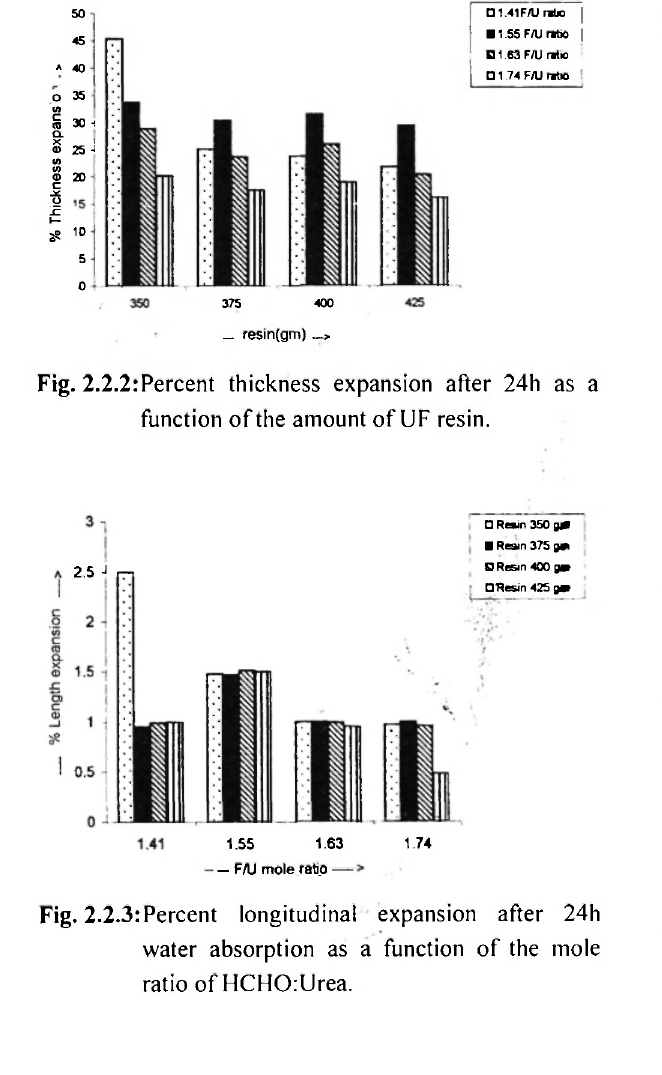
Fig. 2. 2.4: Percent longitudinal expansion after 24h as a function of the amount of UF resin. UF resin with an F/U 1.44 mole ratio using 350g of resin to the lowest value 0.48% for UF resin with a l .74 mole ratio and 425g of resin. No particular order is observed with varying mole ratios of F/U or varying amounts of resin